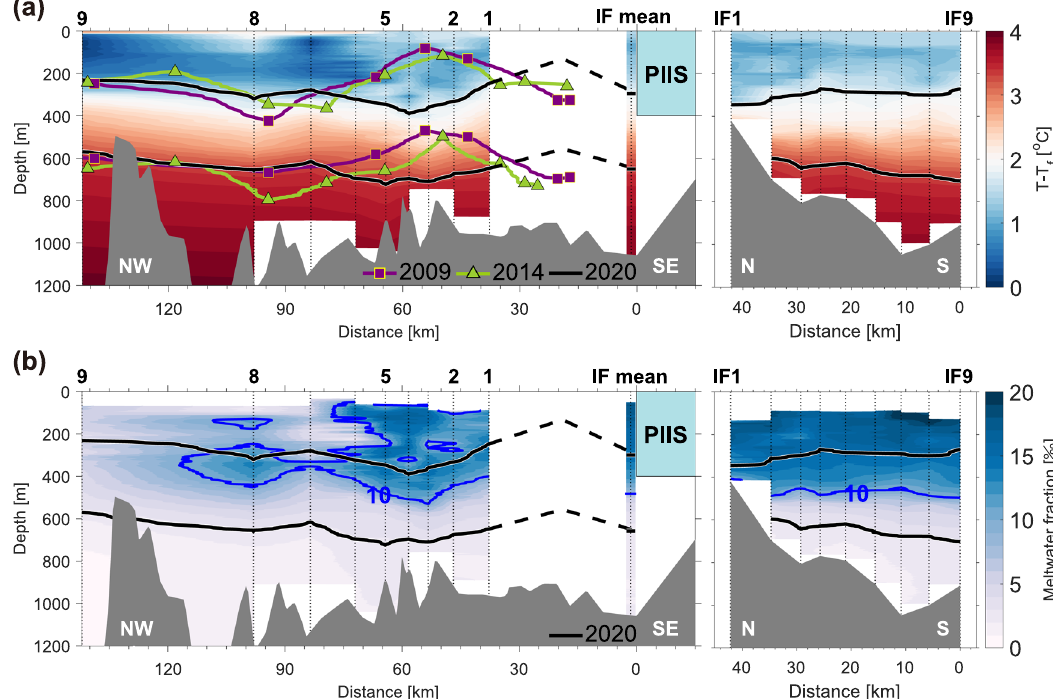
Fig. 2 PIB hydrography in 2020. a Vertical distribution of the temperature above the in situ freezing point (T f ) across PIB (left panel) and along the PIIS front (right panel, IF line) in 2020. The 27.47kg/m 3 and 27.75 kg/m 3 (potential density) isopycnals in 2009, 2014 and 2020 are indicated by solid purple, green and black lines, respectively. Dashed black lines denote the simulated depths of the 27.47 kg/m 3 and 27.75 kg/m 3 isopycnals in 2020 (Methods). b Same as in a , but this panel shows the meltwater fraction in 2020. Blue contours indicate a 10 ‰ meltwater fraction. Values at depths with unreliable meltwater fractions were excluded